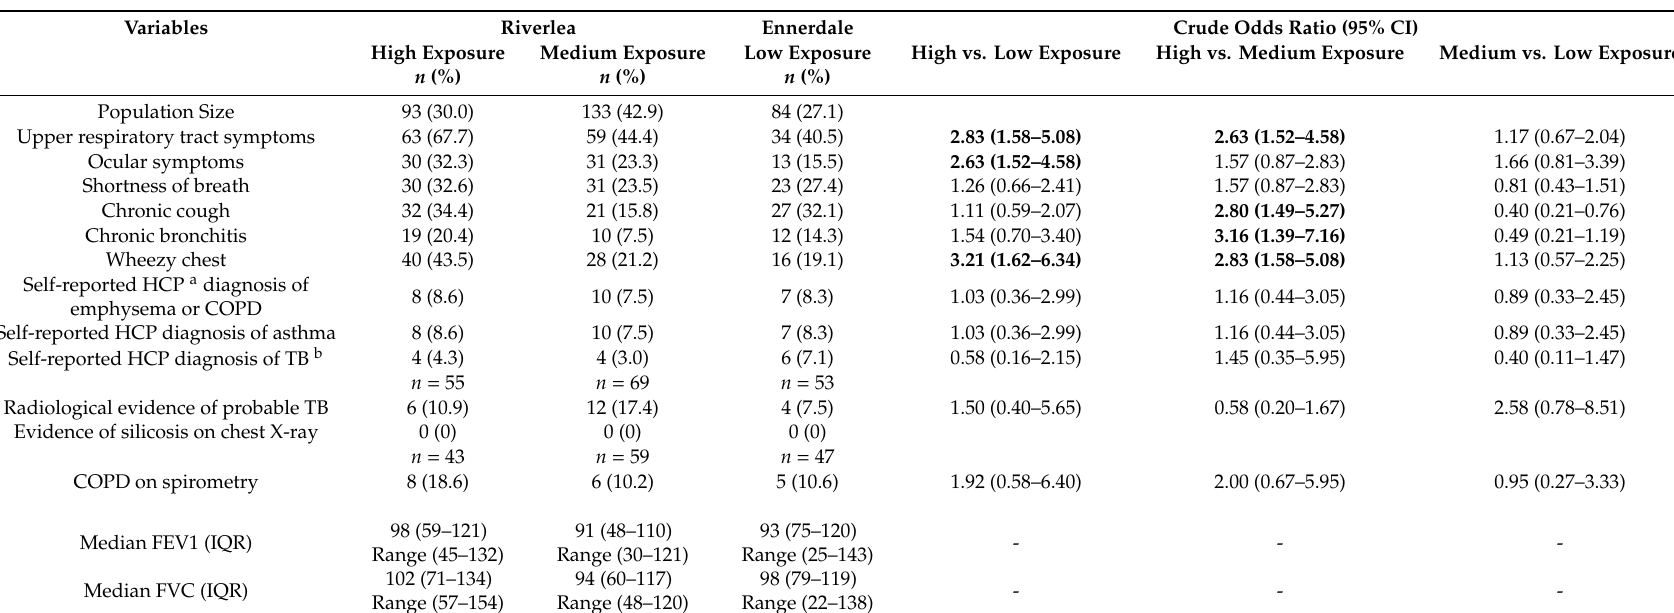
Table 3. Descriptive and univariate analysis with crude odds ratio and 95% confidence intervals of respiratory symptoms, self-reported respiratory conditions diagnosed by a healthcare practitioner (HCP), and objective findings of respiratory conditions by exposure